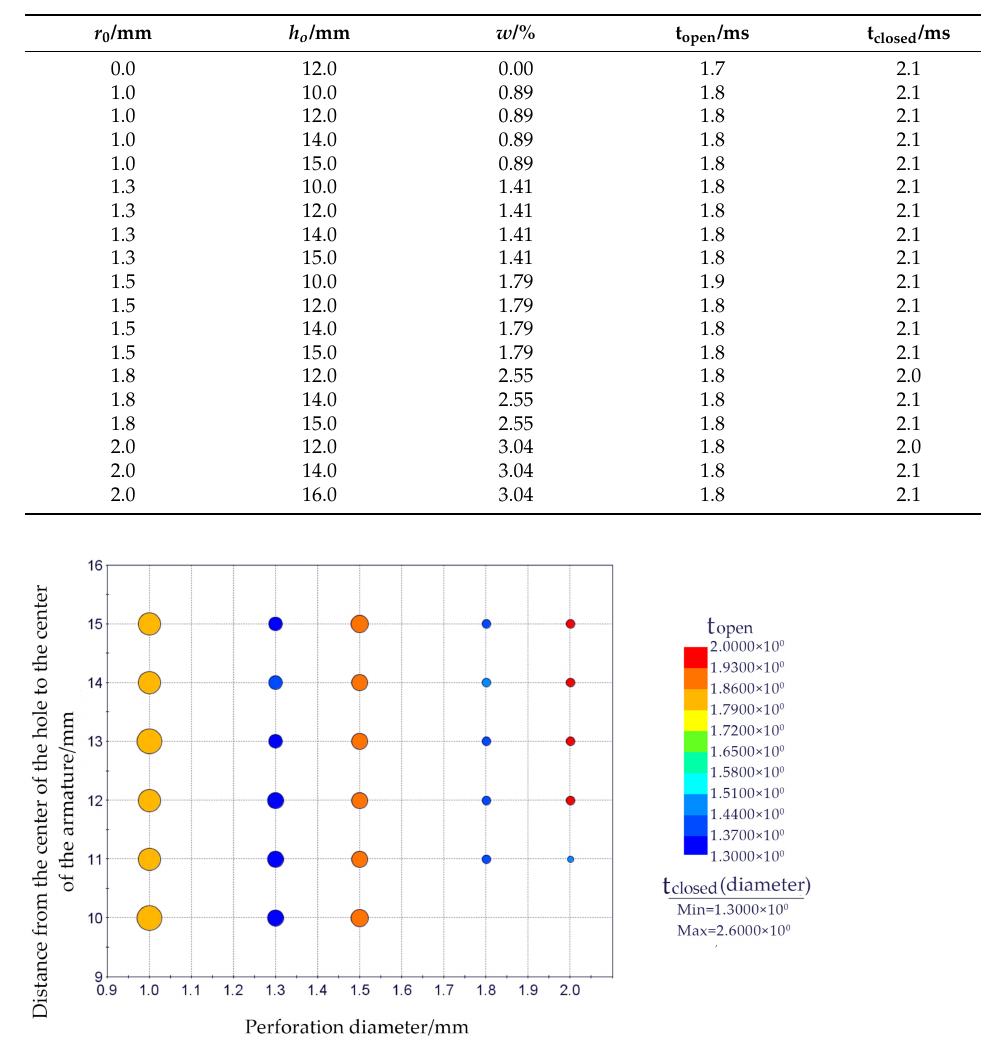
Table 2. Relationship between the drilling radius and position of the yoke area and the dynamic response of the solenoid valve.